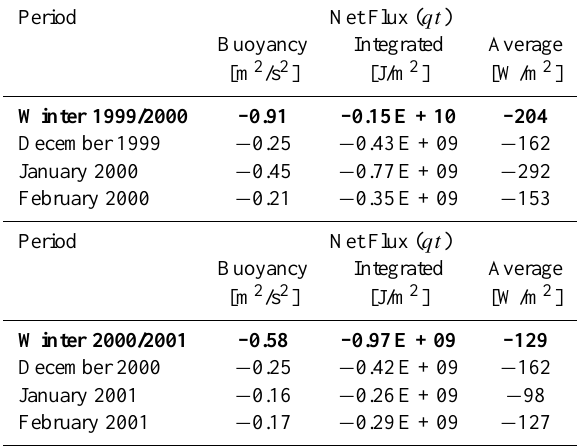
Table 1. Heat and buoyancy loss calculated for the buoy site